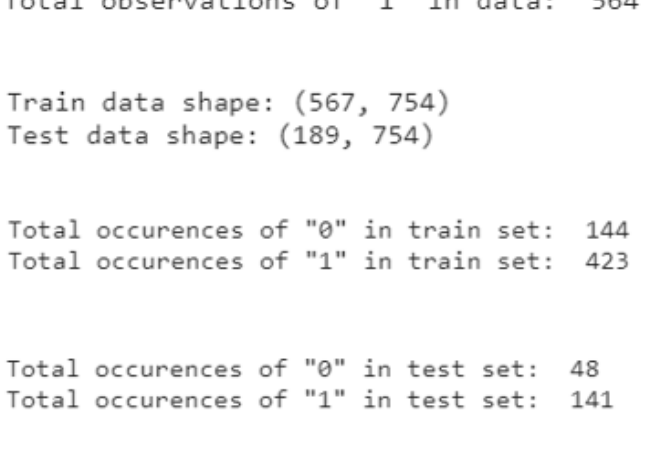
Figure 5. The output of data splitting.